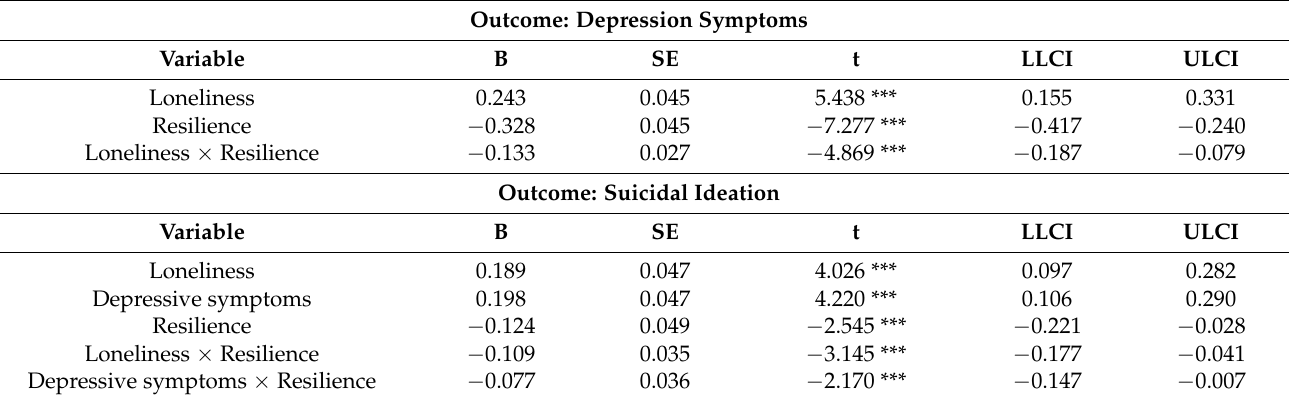
Table 4. Moderating effect of resilience on the mediation model ( n = 538).